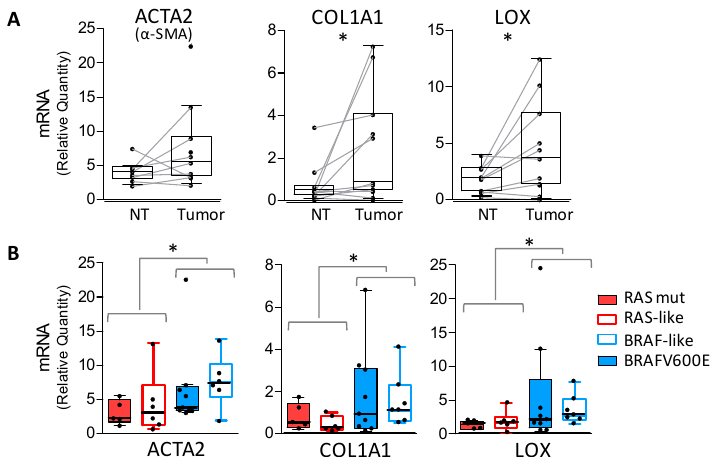
Figure 2. α -SMA, COL1A1 , and LOX gene expression in human thyroid cancers. ( A ) Boxplot with a scatterplot showing mRNA expression of α -SMA ( ACTA2 gene), COL1A1 , and LOX genes using quantitative RT-PCR in paired non-neoplastic thyroids (NT) and thyroid tumors. ( B ) The same genes displayed in tumor samples stratified for driving lesion or BRAF-/RAS-like signaling. qRT-PCR data are shown as a relative quantity normalized to the HPRT gene used as endogenous control for RNA input normalization. Each dot represents the mean of three technical replicates. * p -value < 0.05 using a Wilcoxon . matched test for pairs NT/tumor or the Mann-Whitney test.